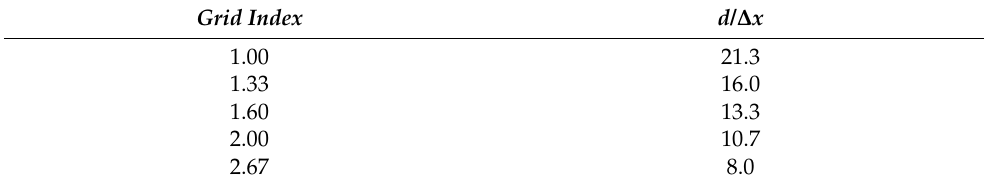
Table 4. Grid parameters for the grid dependency study of the rising bubble simulation.